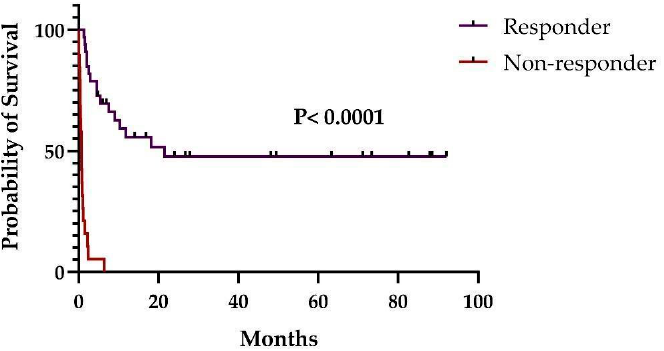
Figure 2. Overall ( A ) and relapse-free survival ( B ) in children and adults (after MSC infusion).